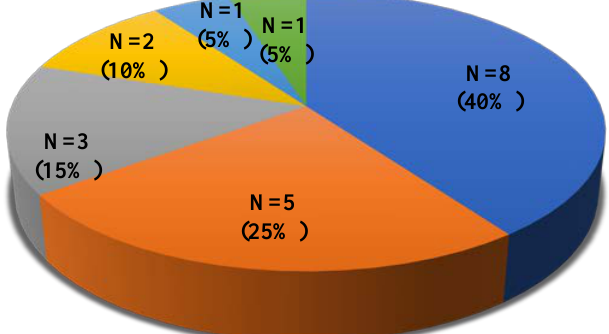
Figure 1. Distribution of etiological agents in COVID-19 patients with liver cirrhosis. HCV, hepatitis C virus; NASH, nonalcoholic steatohepatitis; HBV, hepatitis B virus; AIH, autoimmune hepatitis.